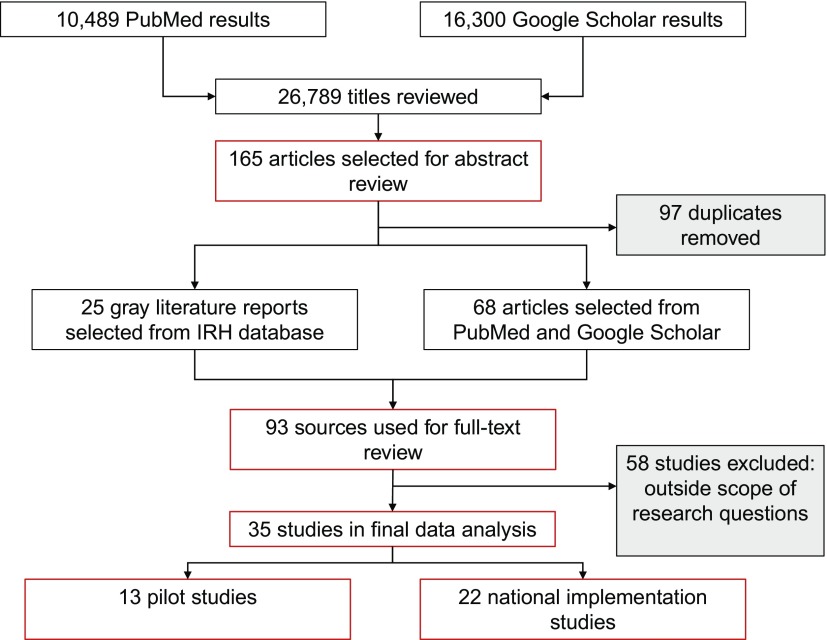
Methodology of Landscape Analysis Review of SDM StudiesAbbreviations: IRH, Institute for Reproductive Health; SDM, Standard Days Method.